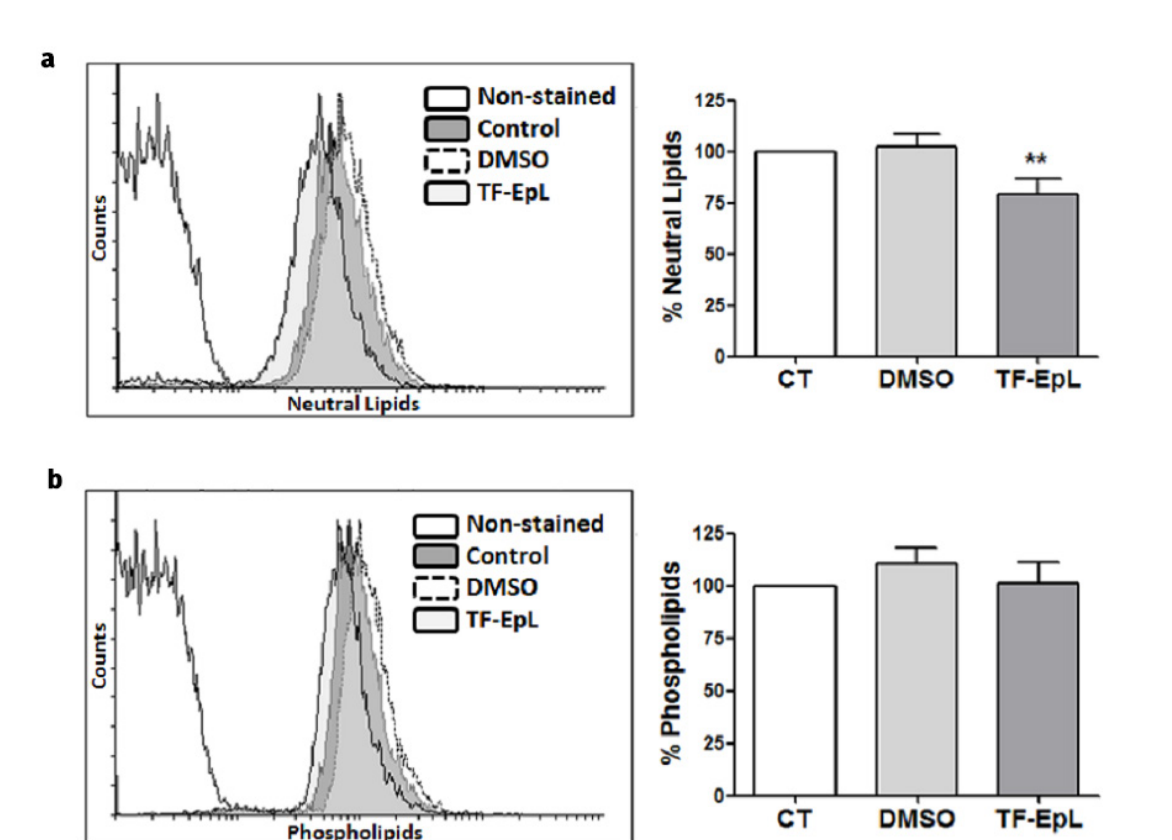
Figure 4. Effect of terpenoid fraction of E. pruniformis leaves (TF-EpL) on the synthesis of total lipids on Leishmania . Promastigotes were incubated in the presence or absence of 43.60 μg/mL TF-EpL for 24 h. Cells were labeled with Nile Red (1 μg/mL) and the percentage of neutral lipids (a) and phospholipids (b) were estimated in flow cytometry. Histograms are representative of 3 independent experiments with similar results. p < 0.001 (**), compared to